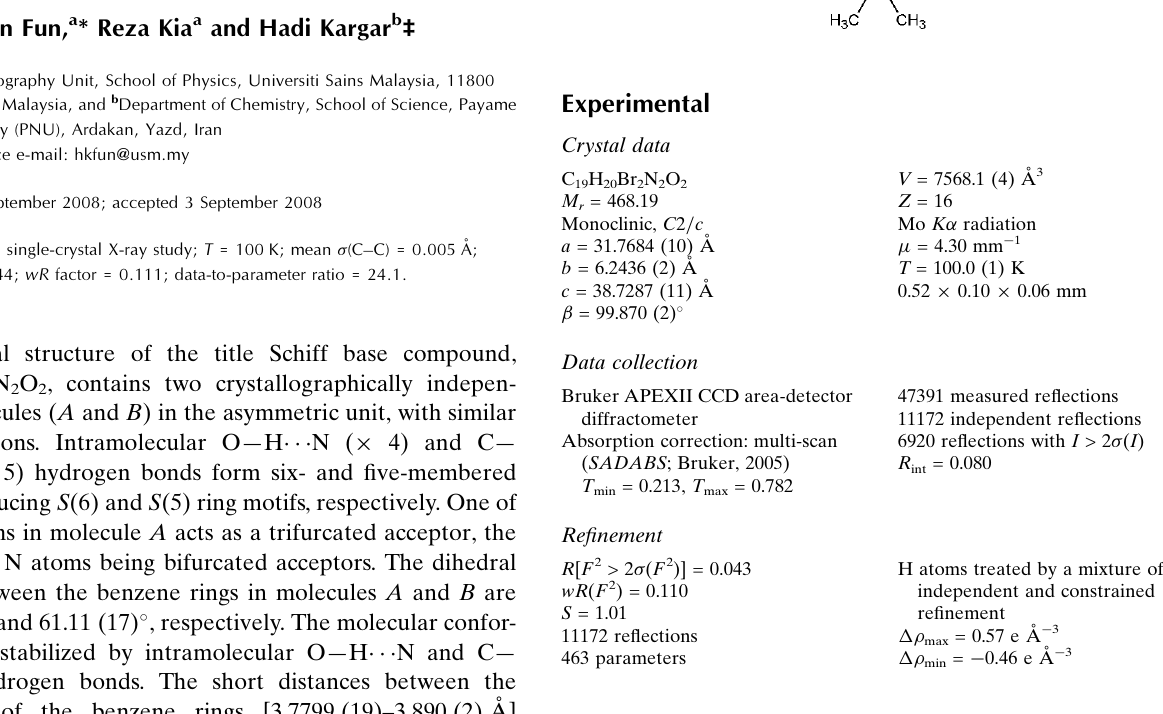
Experimental Crystal data